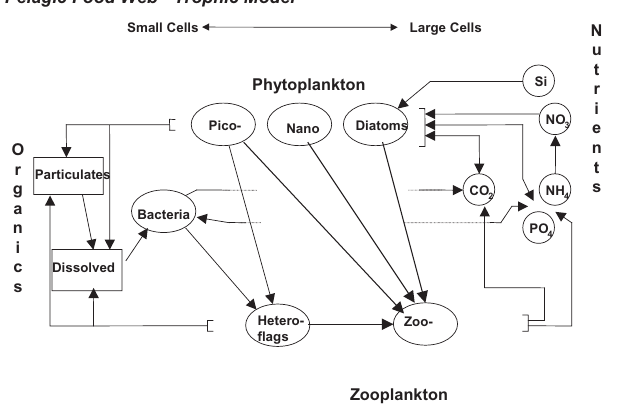
Table 1. The model code and the descriptive names for the